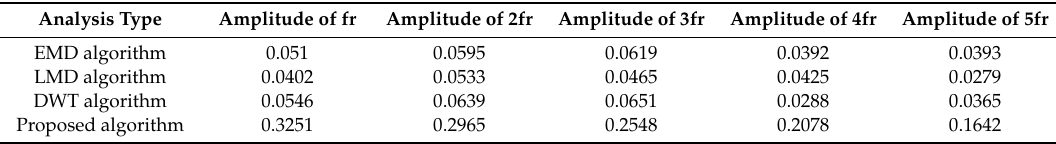
Table 3. The side-band amplitudes for di ff erent analysis method.